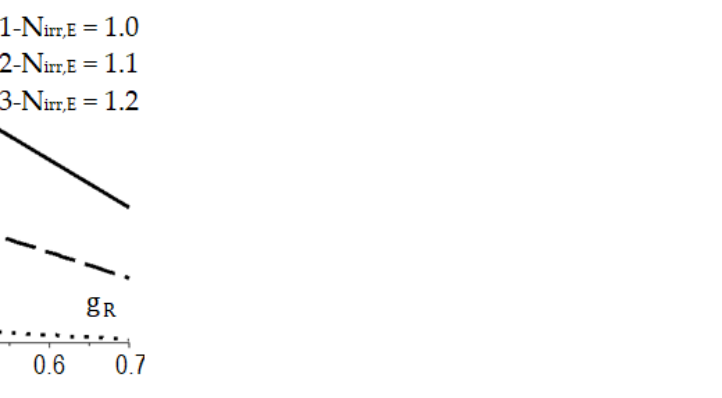
Figure 11. Dependence between the mean log temperature difference at the cold side and the dimensionless thermal conductance at the cold side, ∆T (cid:2902) = f(g (cid:2902) ).